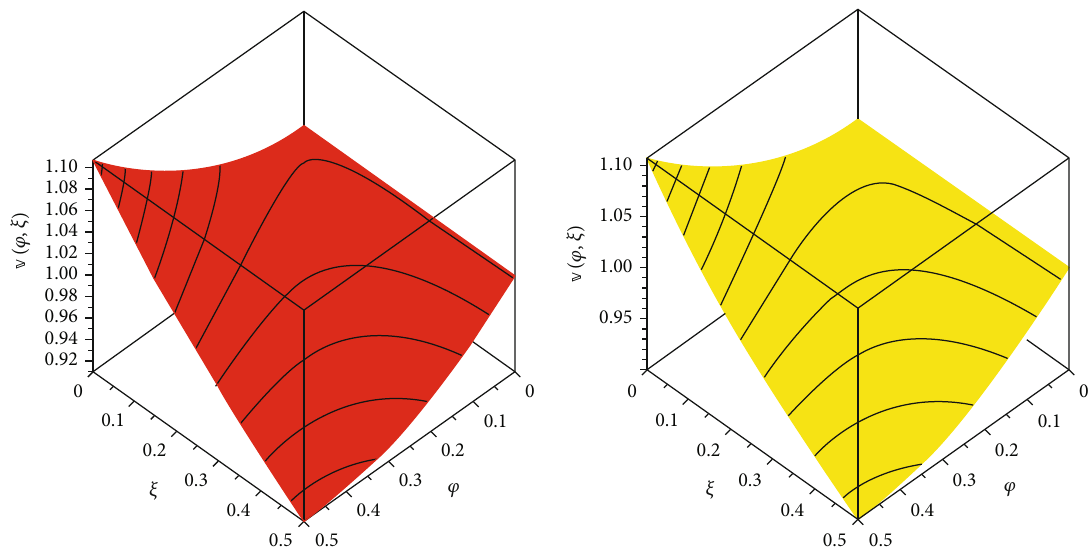
Figure 1: (a) ℘ = 1 and (b) the fractional-order ℘ = 0 : 8 of Example 10.